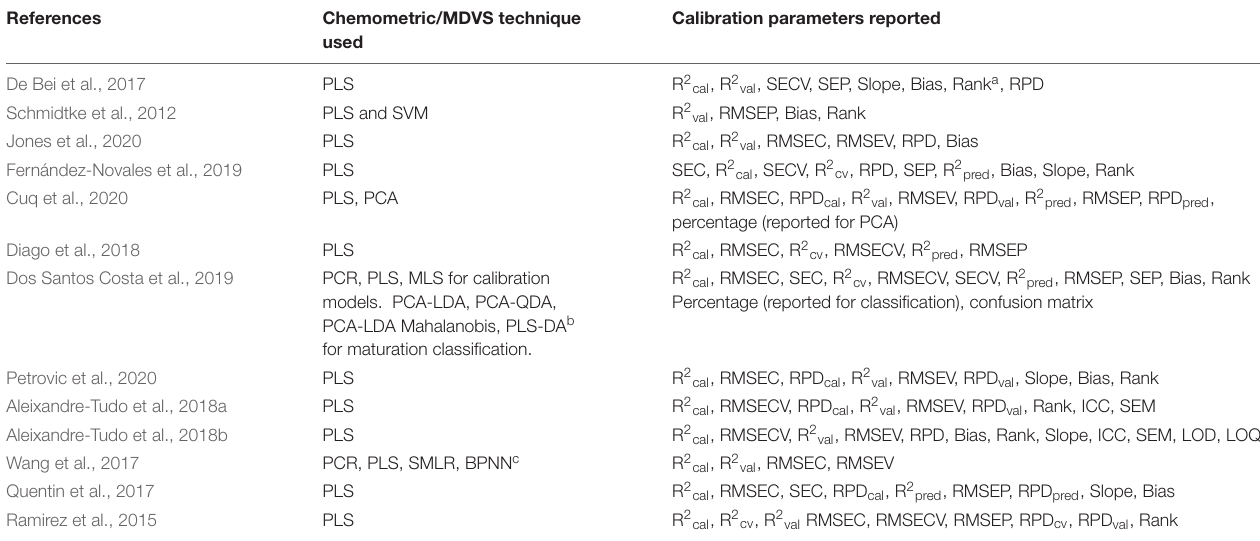
TABLE 1 | Chemometric techniques and calibration parameters reported in discussed